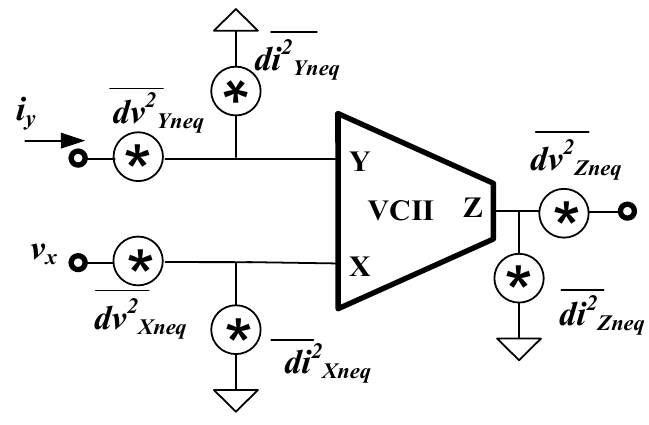
Figure 2. Noise model of VCII [36].